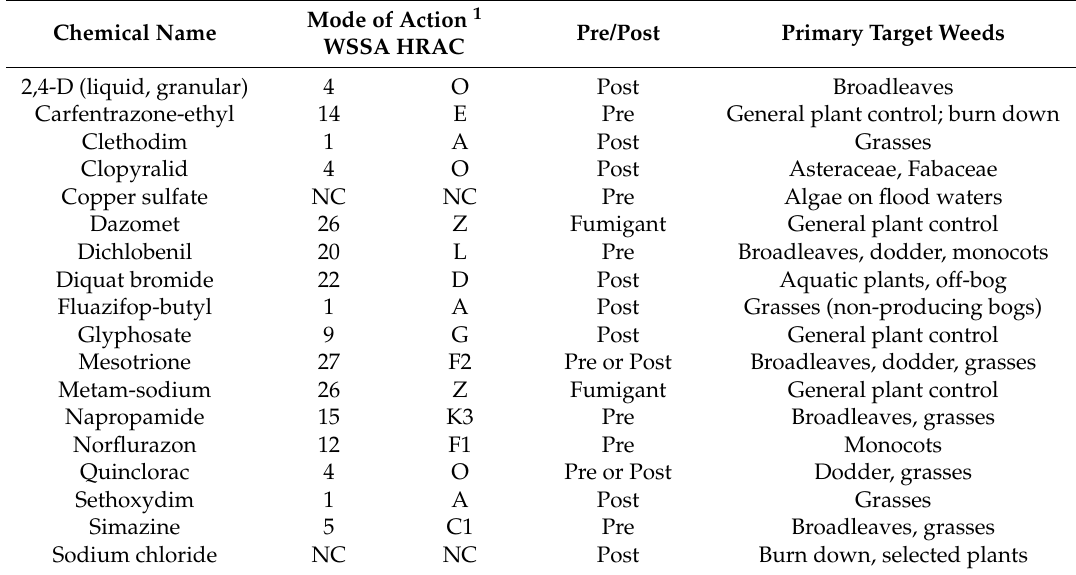
Table 3. List of herbicides currently registered for use in cranberries in the United States. Registration and use patterns may vary among growing regions. Pre = pre-emergence; Post =